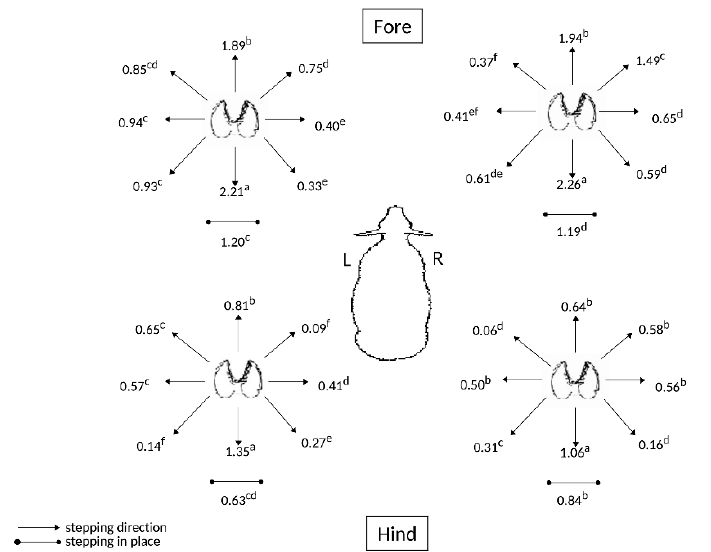
Figure 1. Movement (steps / 20 min) of each limb of sheep ( n = 6) during floor motion, with statistical analysis of di ff erences in the direction of movement within a limb by a Fisher’s comparison test. Di ff erent superscript letters (a,b,c,d,e,f) denote significantly di ff erent responses ( p < 0.05) observed for each individual limb.